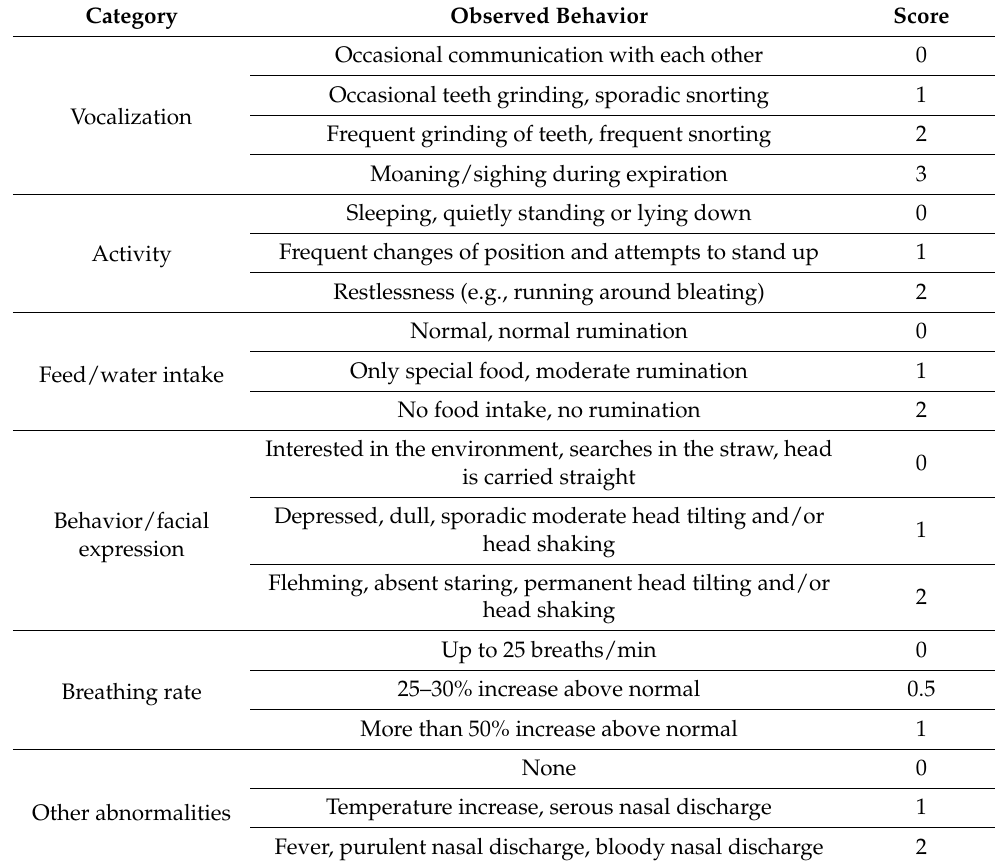
Table A1. Health score as used in the current study. It was based on and modified from Pohl et al. [15].